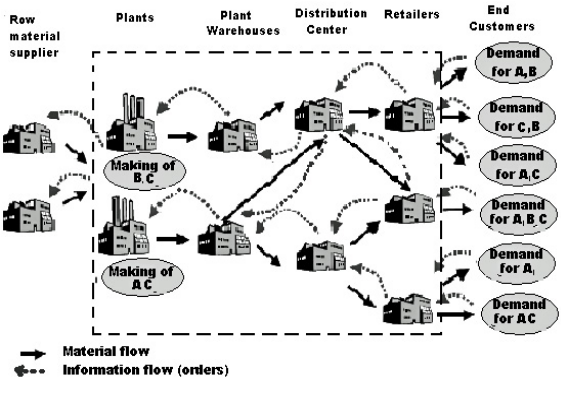
Fig. 3: Structure of supply chain network